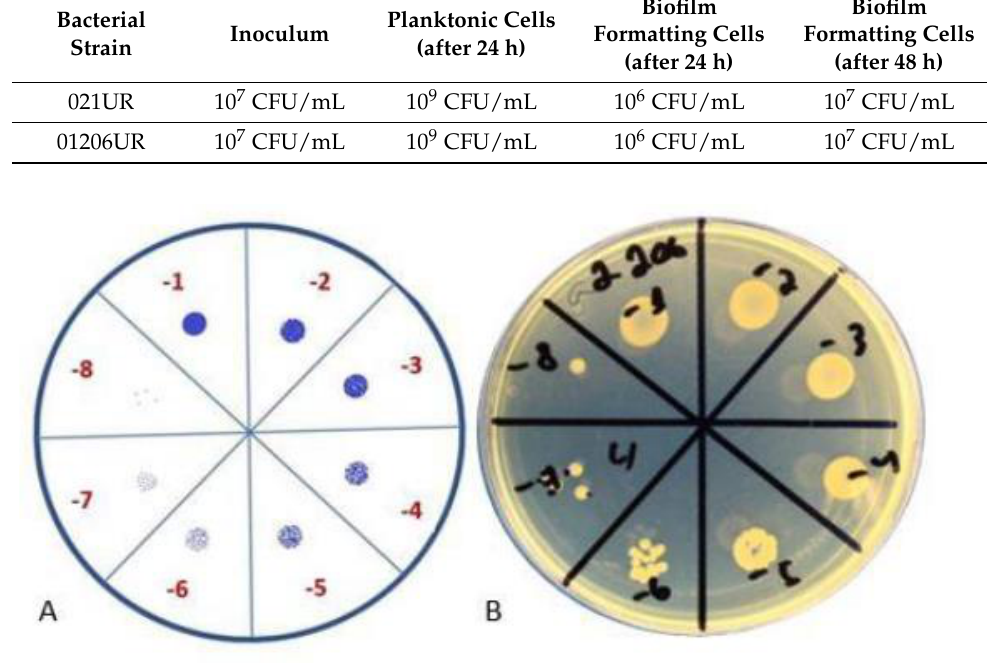
Figure 3. Colony-forming unit spot test. ( A ) Schematic representation; ( B ) visual representation.